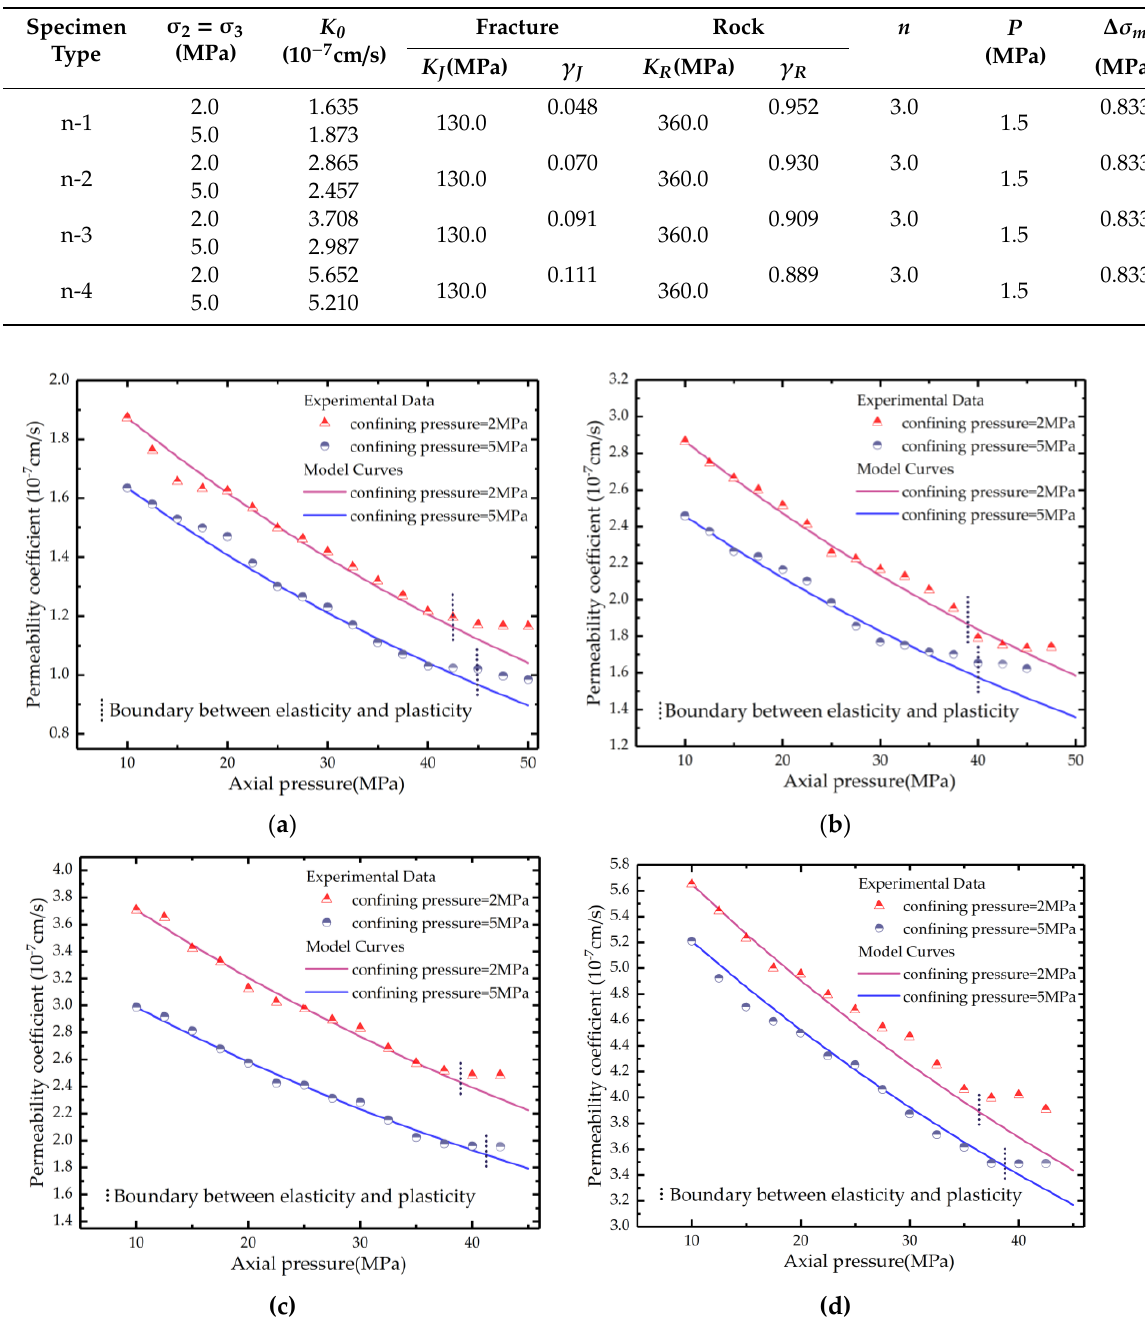
Figure 7. Model fitting to the permeability of the filling fracture specimens: ( a ) fracture aperture of 5 mm; ( b ) fracture aperture of 7.5 mm; ( c ) fracture aperture of 10 mm; ( d ) fracture aperture of 12.5 mm. Table 1. Parameter values of the permeability model.